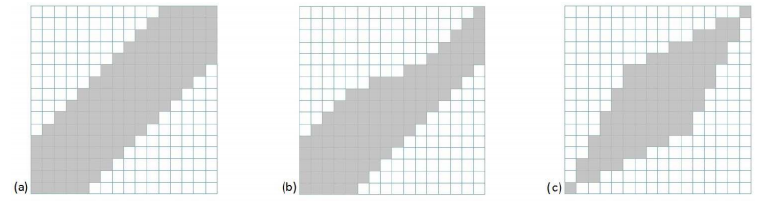
Figure A2. ( a ) Sakoe–Chiba band, ( b ) asymmetric Sakoe–Chiba band, and ( c ) Itakura